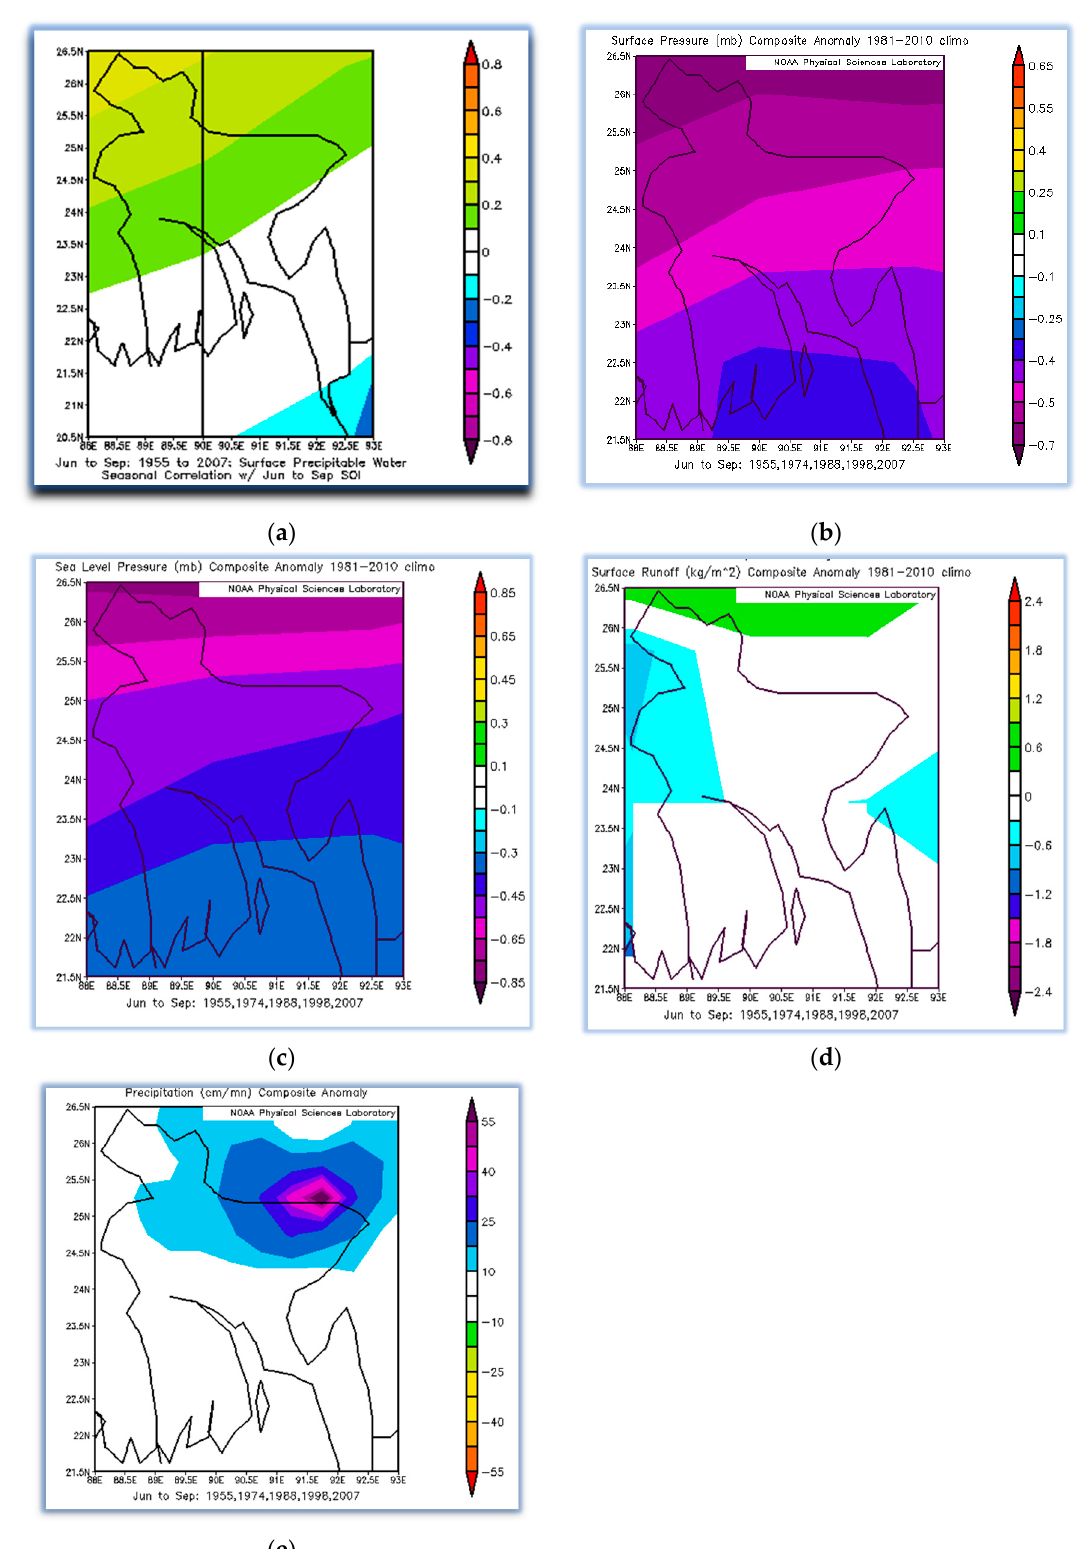
Figure 5. Synoptic conditions ( a ) surface precipitable water, ( b ) surface pressure, ( c ) sea level pressure, ( d ) surface runoff, and ( e ) precipitation anomaly) during La Niña.